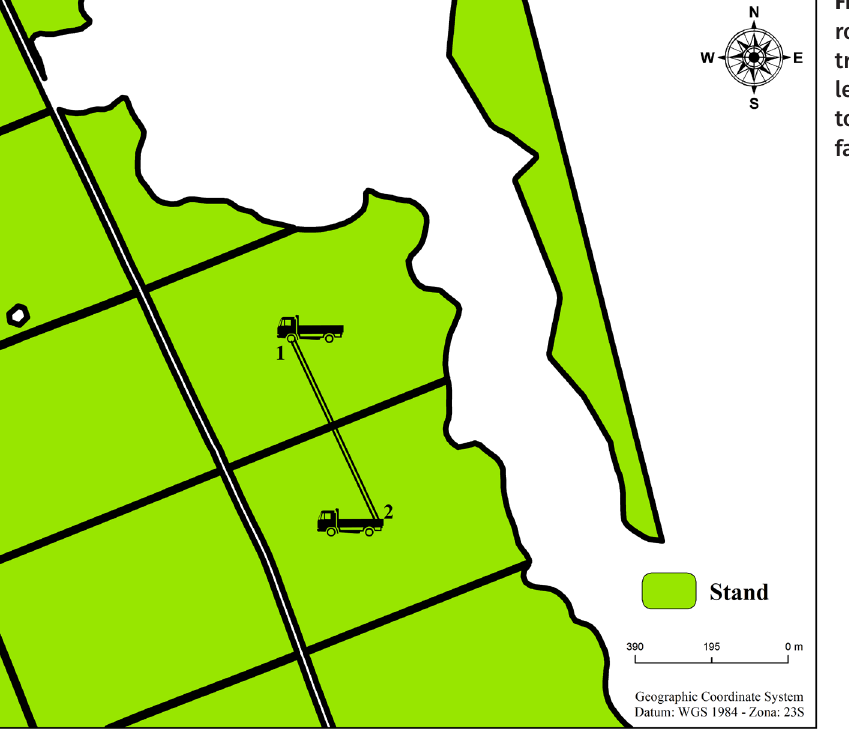
Figure 5. Scheme of double rout applied to wood transportation which the truck leaves the stand 1 and comes to stand 2 before return to